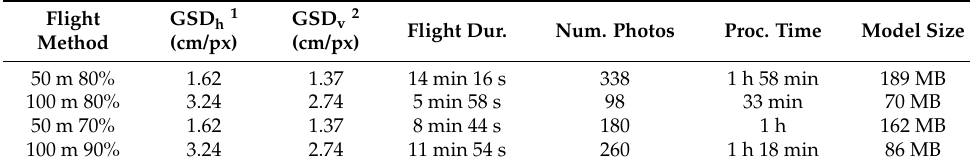
Table 3. Information such as GSD at each flight method applied in this study.